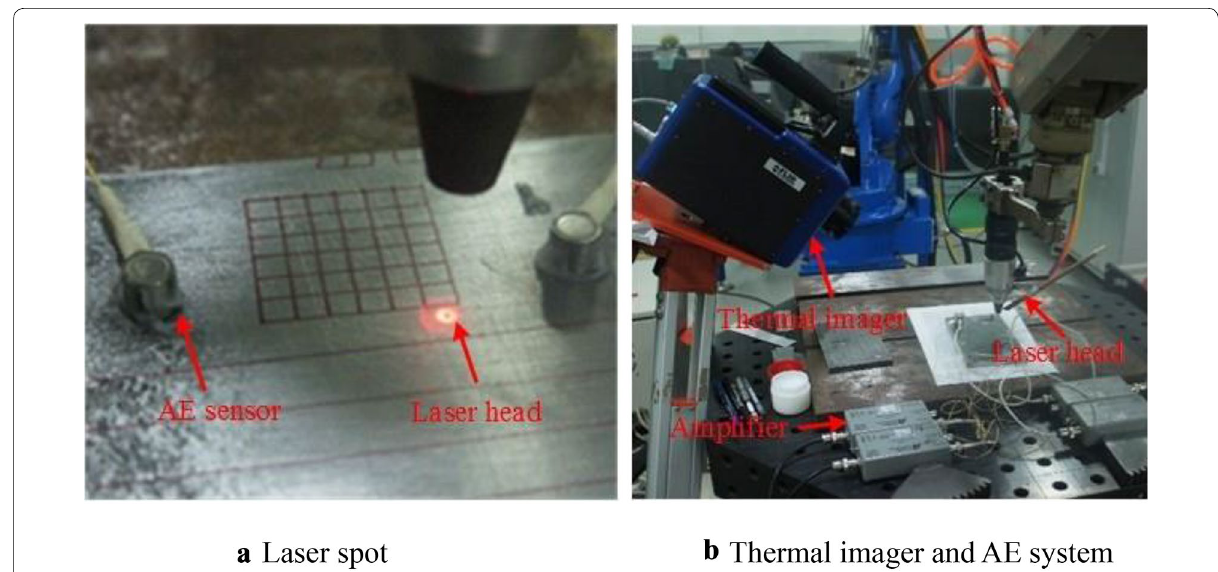
Figure 1 Laser experimental setup